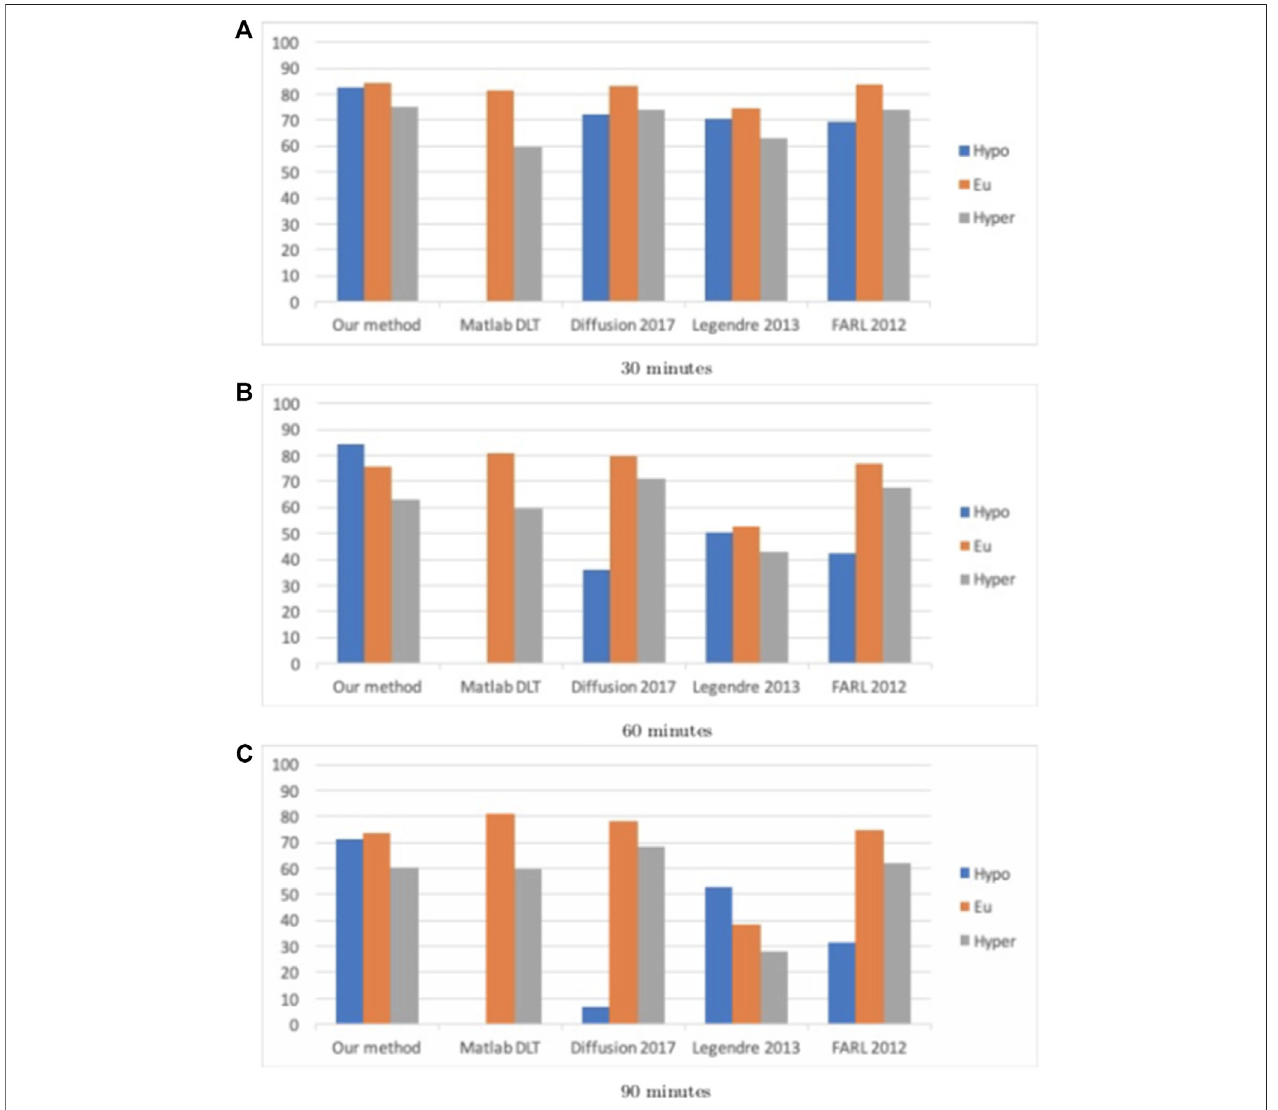
FIGURE 2 | Percentage accurate predictions and predictions with benign consequences in all three BG ranges (blue: hypoglycemia; orange: euglycemia; grey: hyperglycemia) for dataset J, for all fi ve methods for different prediction windows (30, 60, and 90 min).